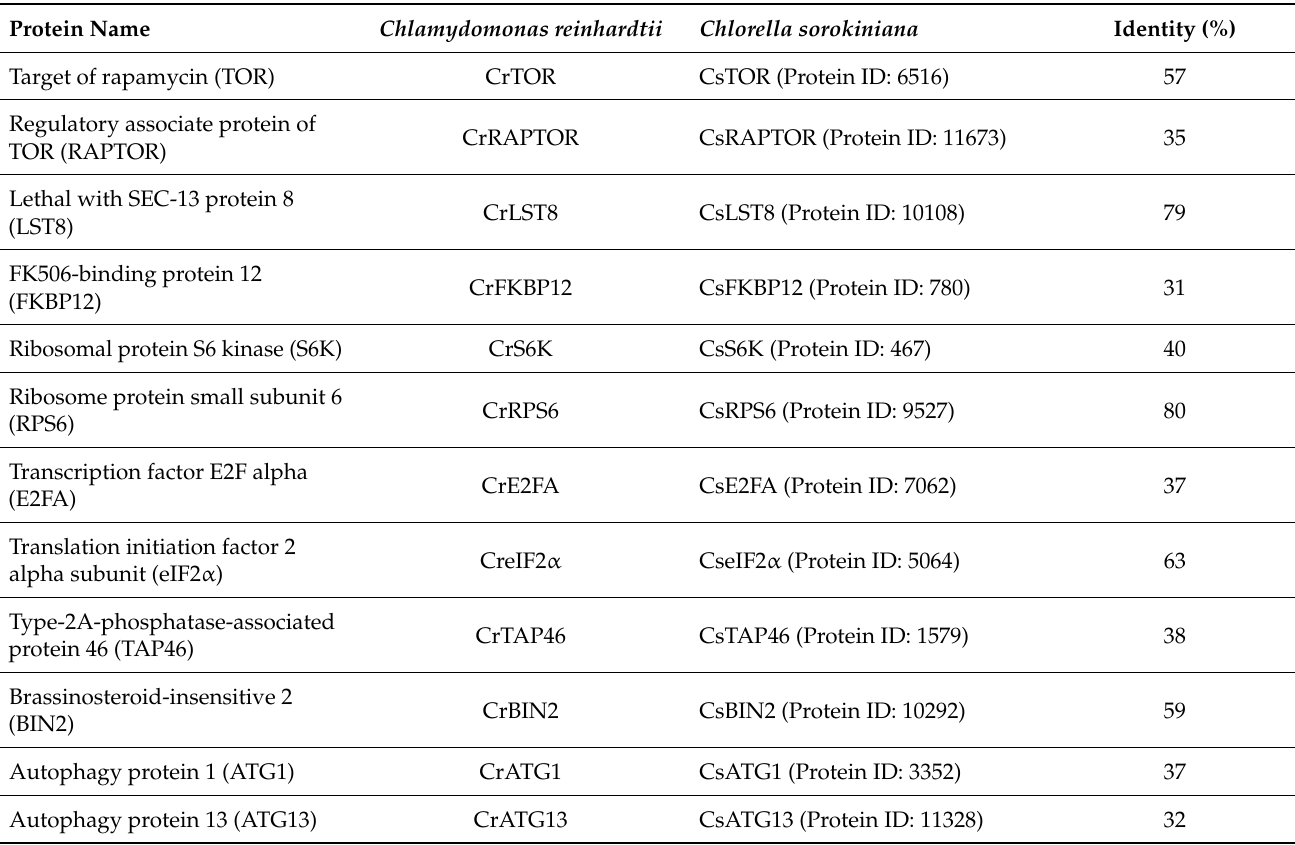
Table 1. The putative components of TOR signaling pathway in Chlorella sorokiniana